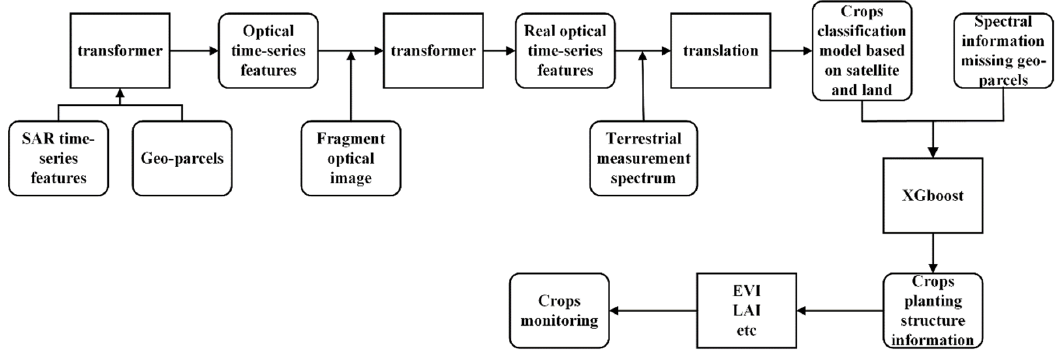
Figure 2. Workflow of the improved model for crop classification in cloudy and rainy regions.